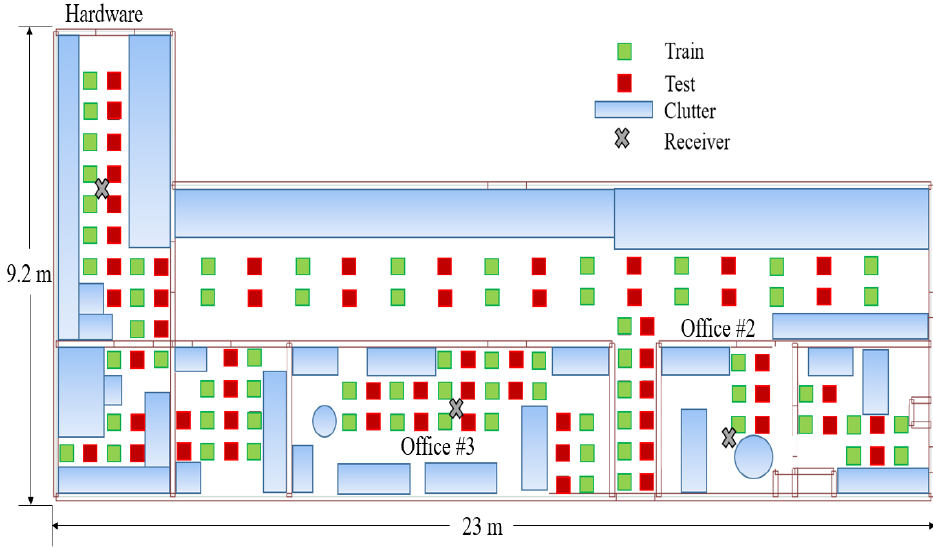
Figure 13. Experimental indoor laboratory environment used to test the indoor localization system and X310 SDR